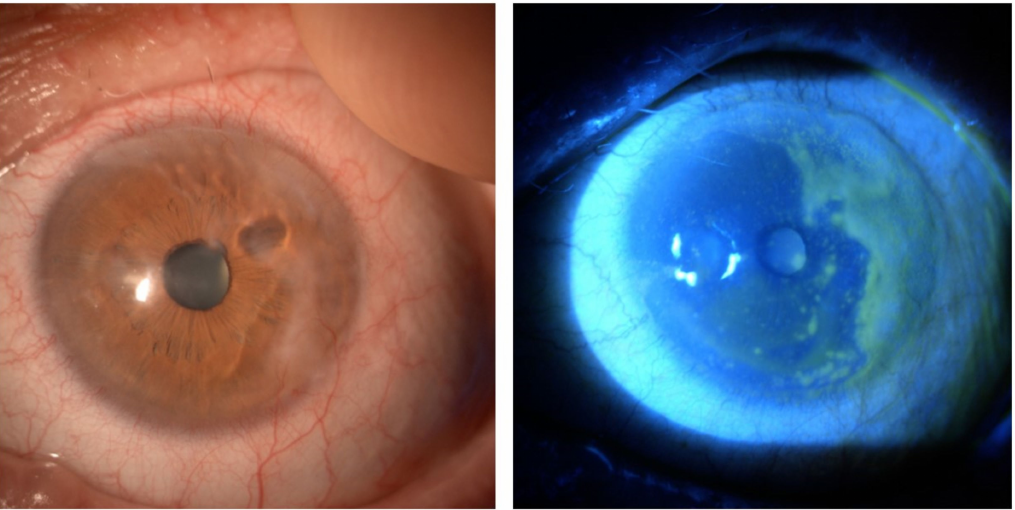
Figure 2. A case of limbal stem-cell deficiency (LSCD) in a patient with chronic graft-versus-host disease